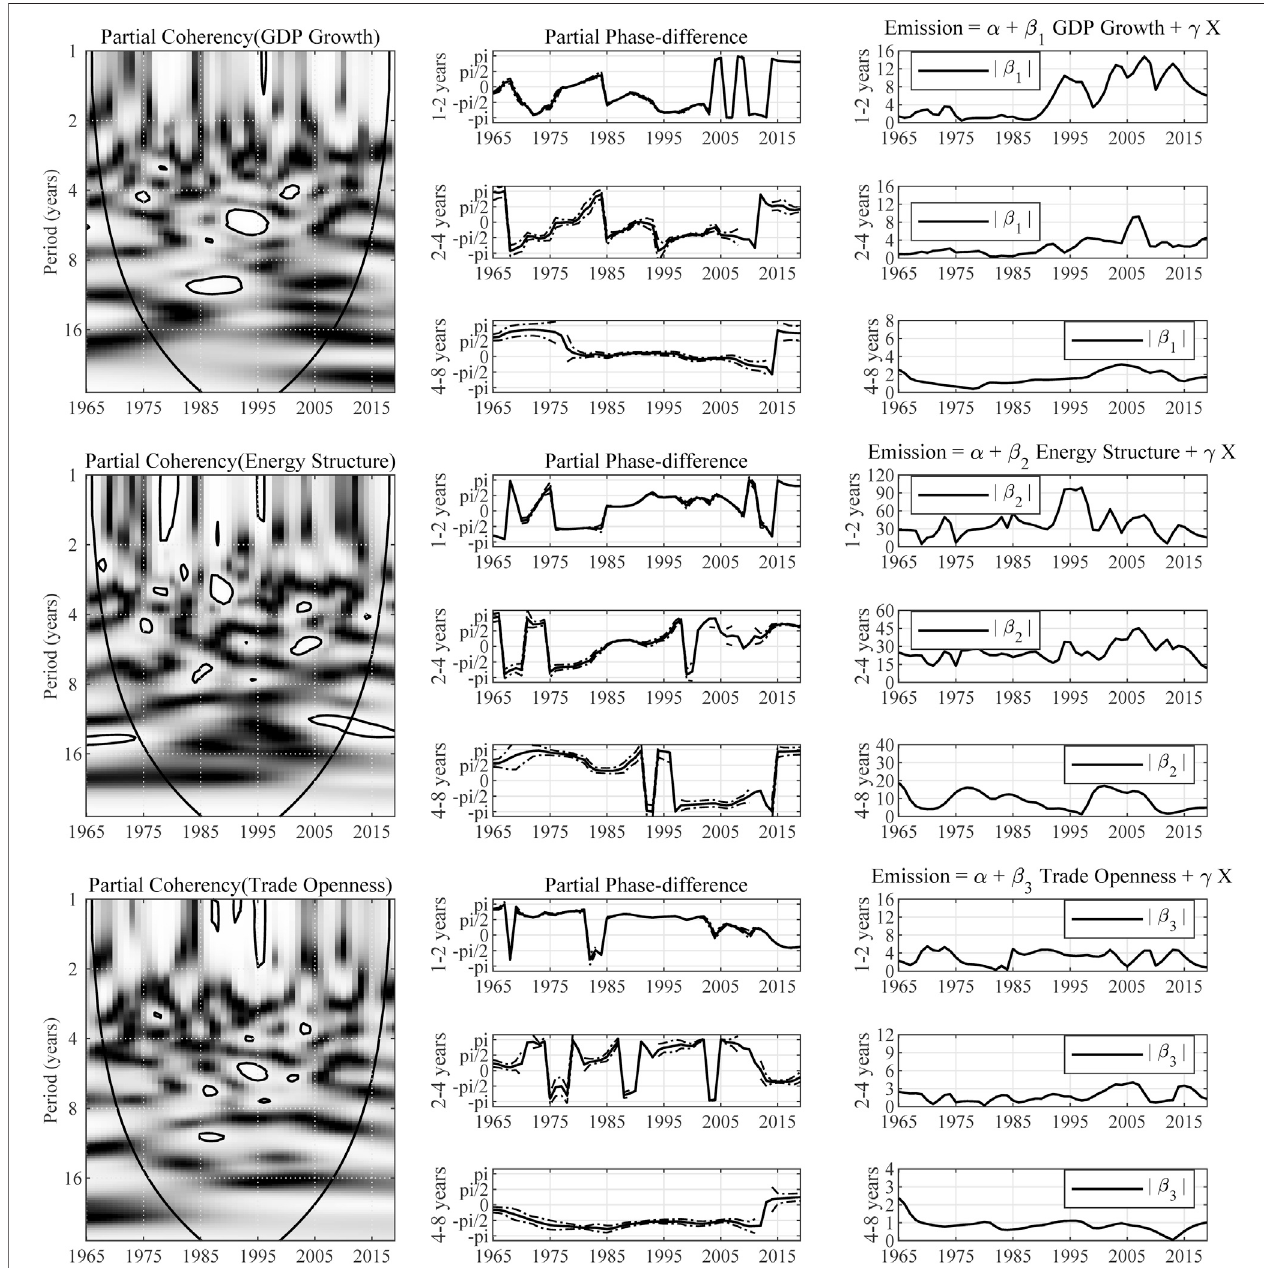
FIGURE 9 | Multivariate wavelet analysis results for South Africa. Note: The expression “ Partial Coherency (Z) ” denotes the partial coherency between variable Z andcarbonemission,controlledforthein fl uencefromotherfactors.Theareasbelowthesymmetricblackconvexcurvethatappearsinthe fi gureofcoherencyarecalled the “ Cone of In fl uence (COI), ” in which the edge effects are profound. Inside the COI, the results tend to be unreliable. The contours in the coherency diagrams indicate 5%signi fi cance level,bootstrappedfor10,000replications.And,thebrightercolorscorrespondtohigher signi fi cance level,anddarkercolorscorrespond tolower signi fi cance level. The dotted lines accompanying the partial phase-difference indicate the 95% con fi dence intervals.